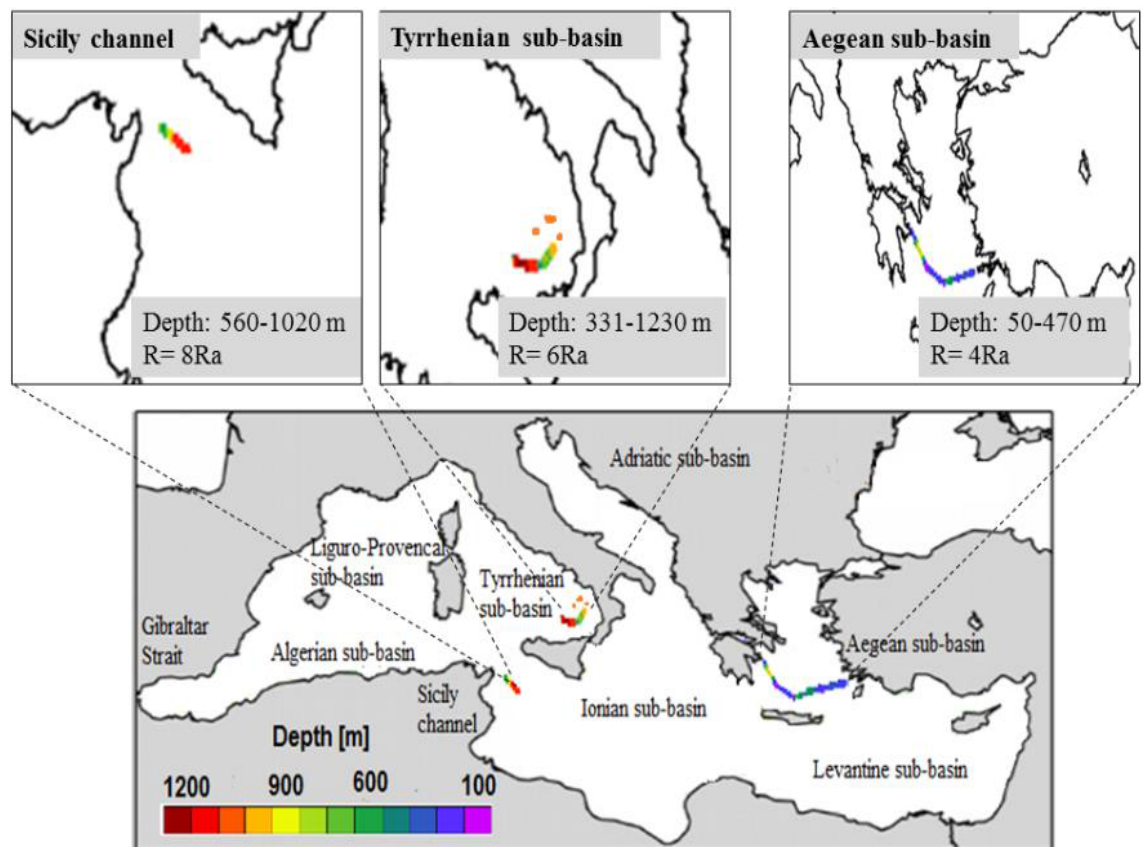
Figure 3. Depth (in metres) and localization of mantle helium injection in the Mediterranean Sea. Table 1. Release rates of mantle helium in the Mediterranean Sea used in the model (see Sect. 3.1.3). Region Prescribed 3 He Flux 3 He / 4